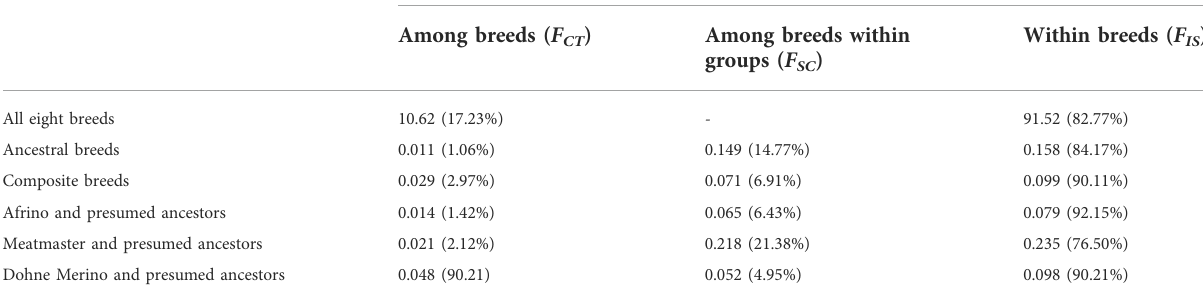
TABLE 3 Analysis of molecular variation.